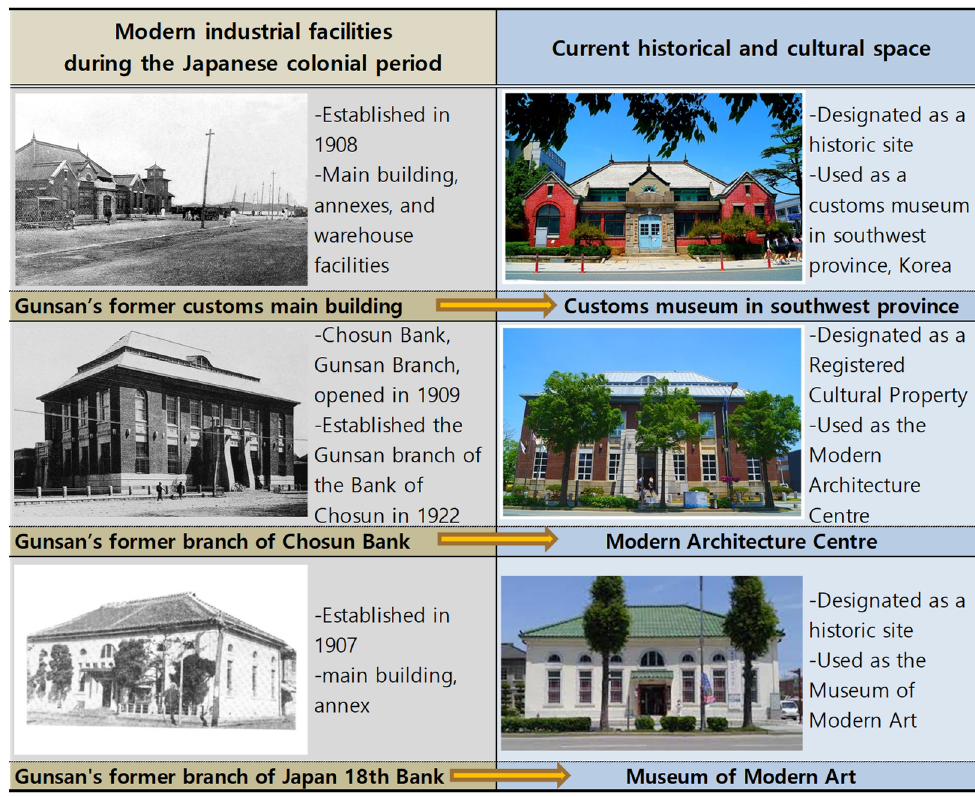
Figure 4. Site-specific resources used as museum spaces in Gunsan .